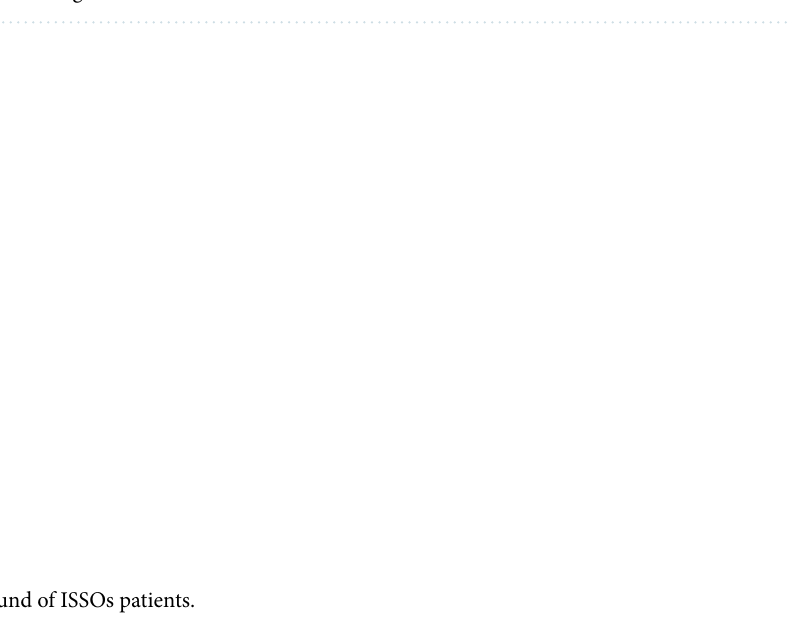
Figure 1. Patient selection diagram.